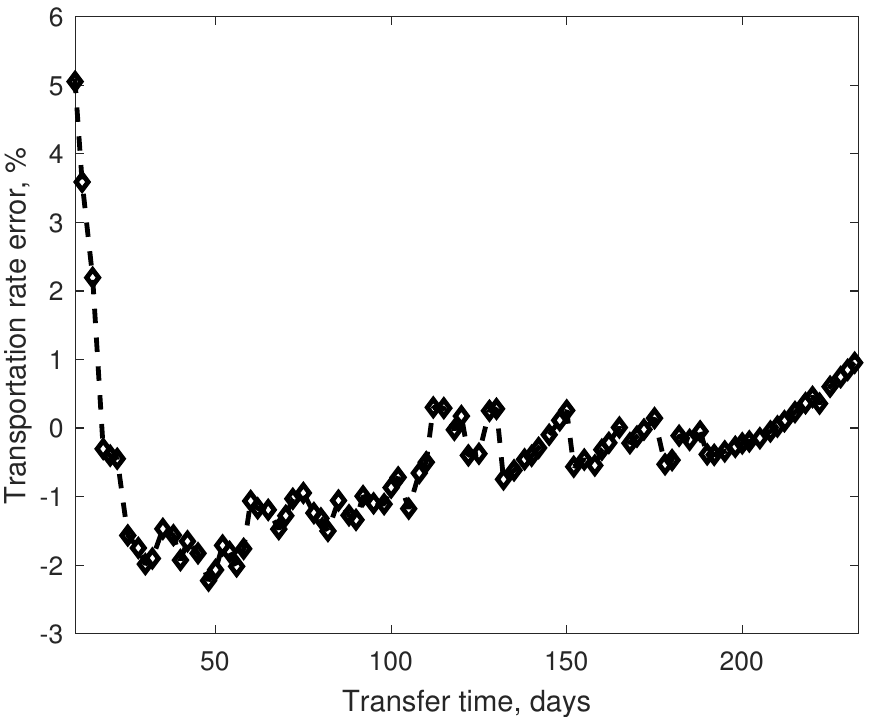
Figure 15. Transportation rate error versus transfer time when T max = 100 mN and I sp = 3500